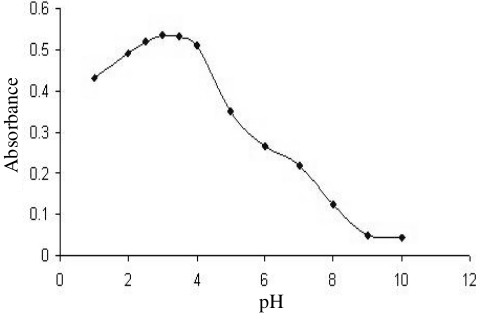
Figure 1. Effect of pH on the absorbance of complex. ( Conditions: Pd(II) 50.0 ng mL -1